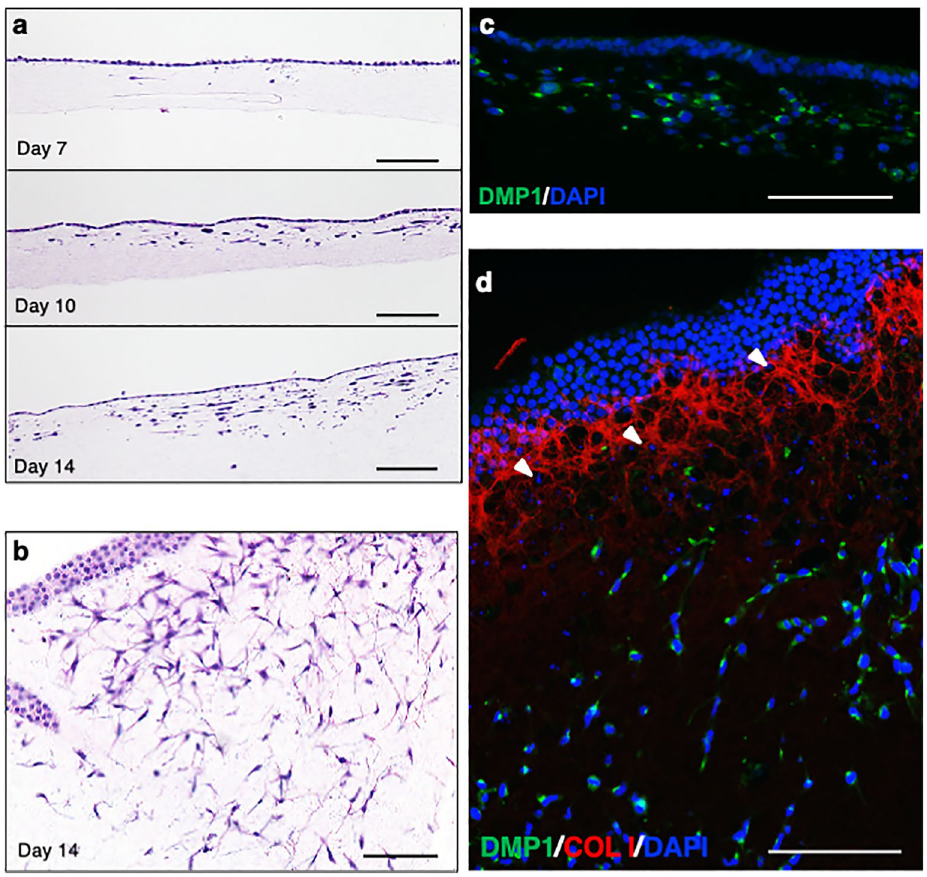
Figure 1. Induction of osteoblastic and osteocytic cells from hiPSCs (414C2) on type I collagen gel. ( a ) Histological findings of vertical sections of induced cells on type I collagen gel at days 7, 10 and 14 by Hematoxylin–Eosin (HE) staining. ( b ) Histological findings of a horizontal section at day 14 by HE staining. ( c ) Histological findings of a vertical section at day 14 with immunostaining for DMP1 (green) and DAPI (blue). ( d ) Histological findings of a horizontal section at day 14 with immunostaining for DMP1 (green), type I collagen (red) and DAPI (blue). Arrowheads show cells surrounded by COL I. Scale bars = 100